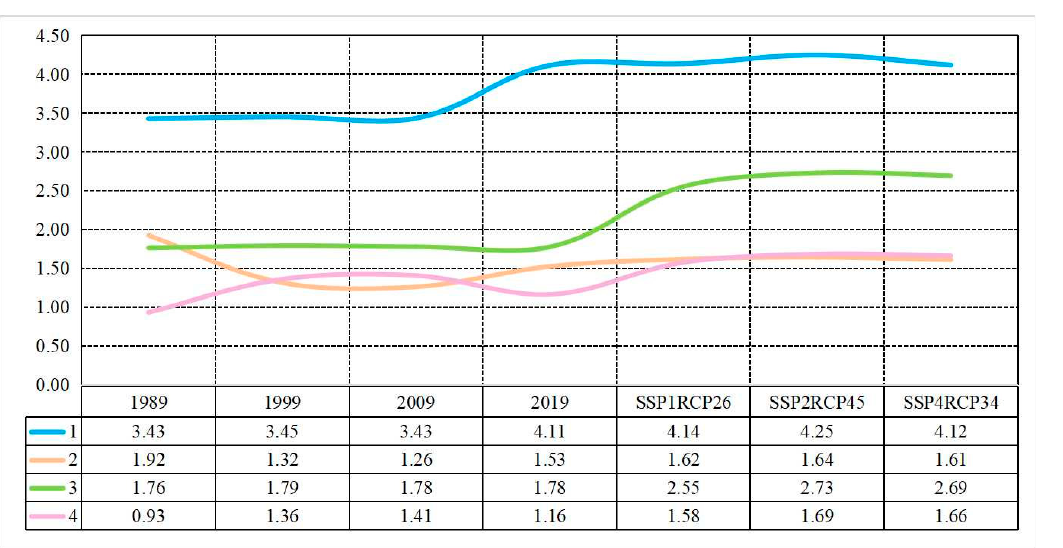
Figure 2. Amount of grain and cropland needed, cropland supplied and guarantee level of cropland in China at national scale, where 1 stands for the demand of grain, 10 11 kg; 2 stands for the cropland demand, 10 8 ha; 3 stands for cropland supplied, 10 8 ha; 4 stands for guarantee rate of cropland, 100%.